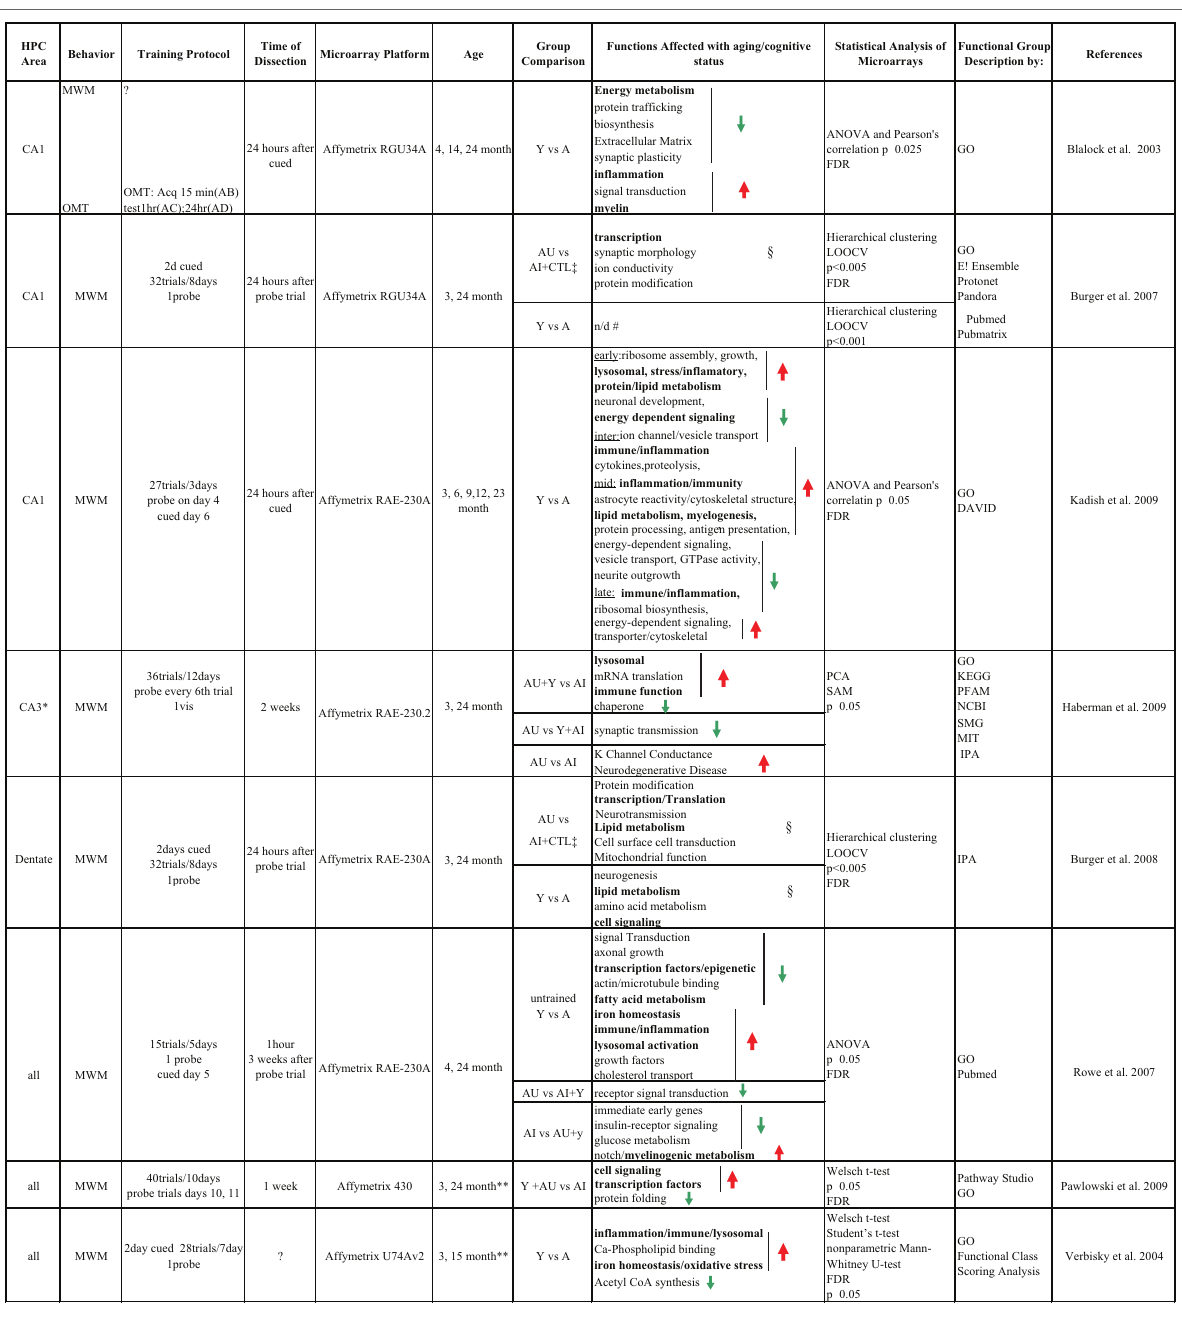
HPC Area Behavior Training